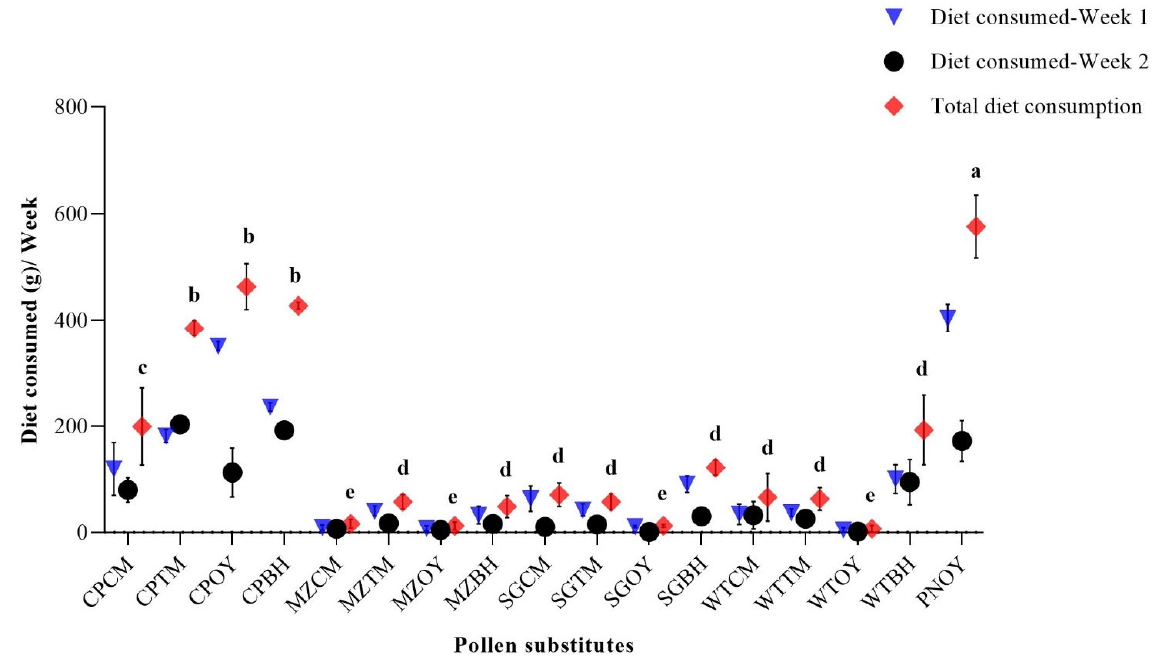
Figure 5. Honey bee diet consumption from various pollen substitutes. Whereas, CPCM = Chickpea flour + Cinnamon powder, CPTM = Chickpea flour + Turmeric powder, CPOY = Chickpea flour only, CPBH = Chickpea flour + Both powders, MZCM = Maize flour + Cinnamon powder, MZTM = Maize flour + Turmeric powder, MZOY = Maize flour only, MZBH = Maize flour + Both powders, SGCM = Sorghum flour + Cinnamon powder, SGTM = Sorghum flour + Turmeric powder, SGOY = Sorghum flour only, SGBH = Sorghum flour + Both powders, WTCM = Wheat flour + Cinna- mon powder, WTTM = Wheat flour + Turmeric powder, WTOY = Wheat flour only, WTBH = Wheat flour + Both powders, PNOY = Pollen only as a control. Different superscript letters indicate signifi- cant differences between total diet consumption. Table 2. Honey bee visit and diet consumption